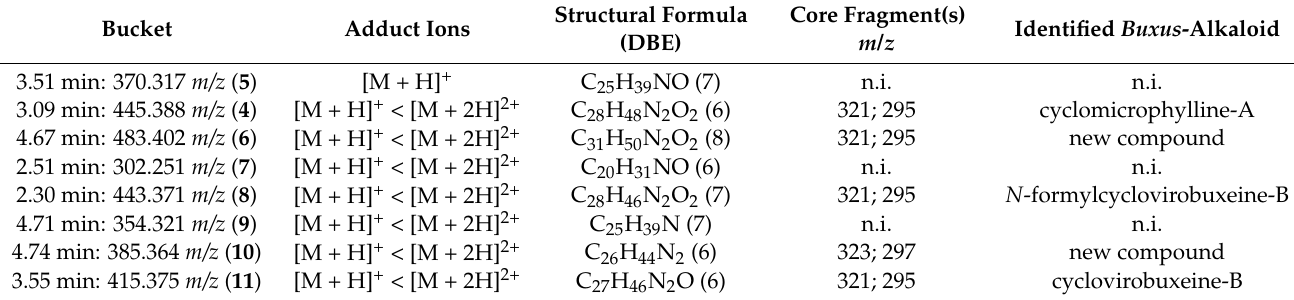
Table 4. LC/MS-characteristics of the compounds with predicted antitrypanosomal activity (compare Figure 5).